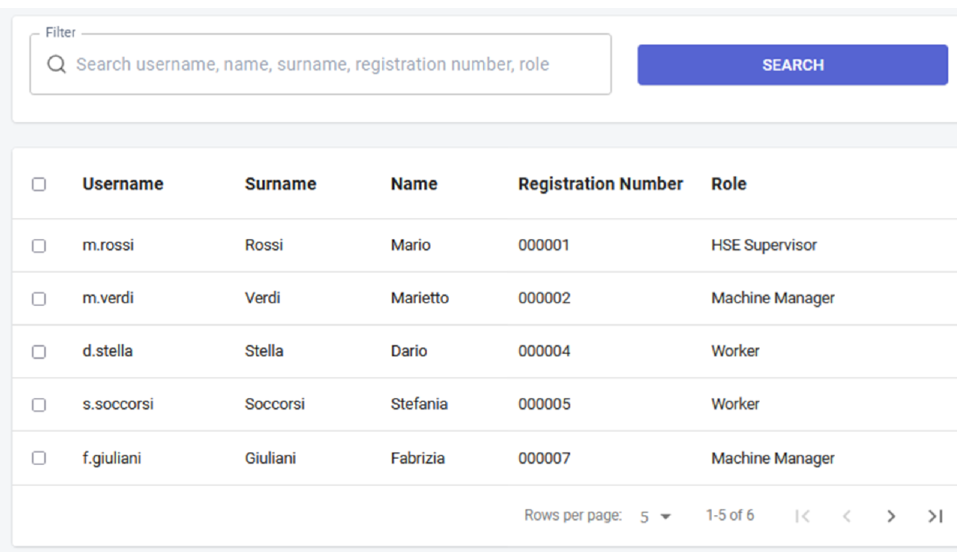
Figure 15. User tab of the Front-end